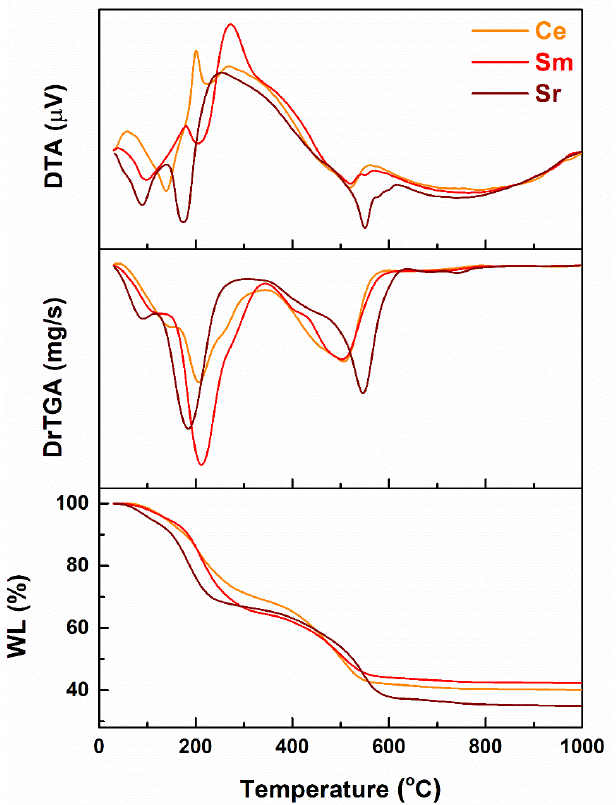
Figure 1. Thermal analyses of the dried gels ( WL = weight loss, DrTGA = derivative of the thermo- gravimetric analysis with respect to time, DTA = differential thermal analysis).